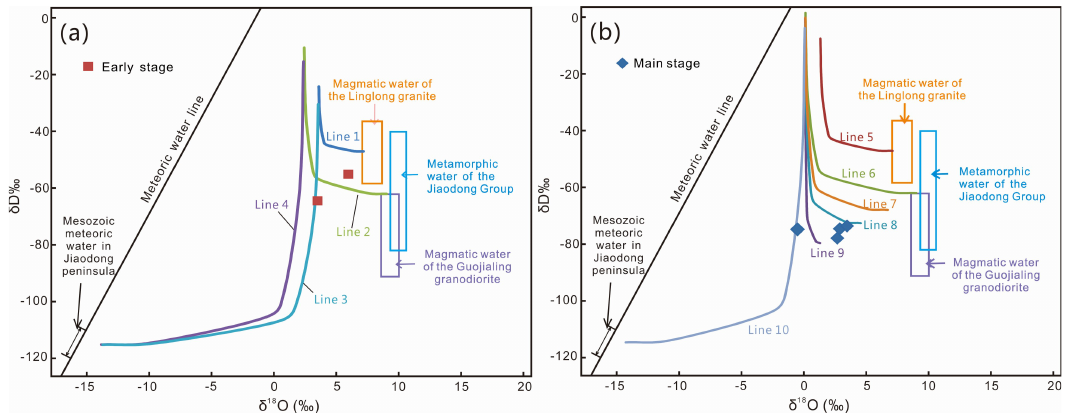
Figure 14. The evolution of the H–O composition during the water–rock